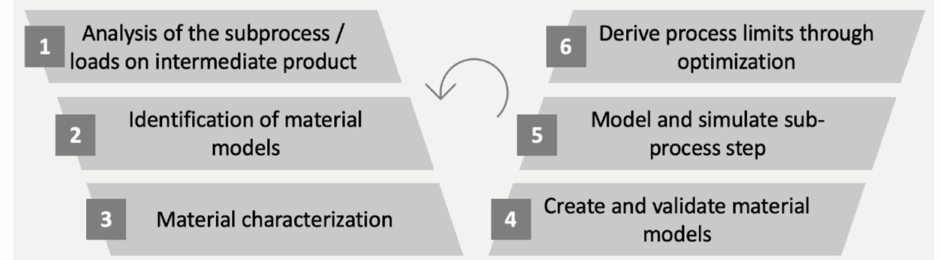
Figure 1. Approach for simulation-based design validation of production processes in cell